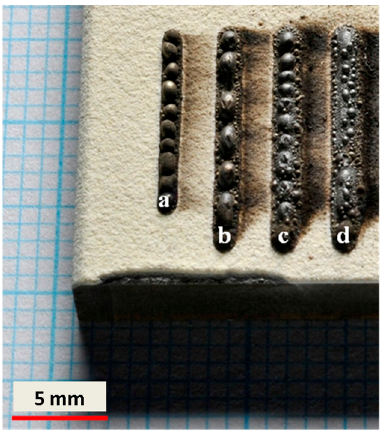
Figure 3. Surface morphologies of clads from alumel feedstock at different parameters from the top view. v S = 400 mm/min, d S = 0.984 mm, f F = 1.7 g/min, f C = f P = 10 L/min. ( a ) P L = 50 W; ( b ) P L = 80 W; ( c ) P L = 100 W; ( d ) P L = 110 W.